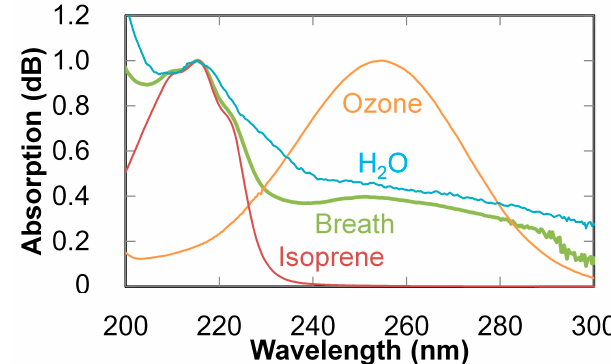
Figure 9. Absorption spectrum of breath (normalized with the peak intensities) compared with absorption spectra of isoprene, water vapor, and ozone.